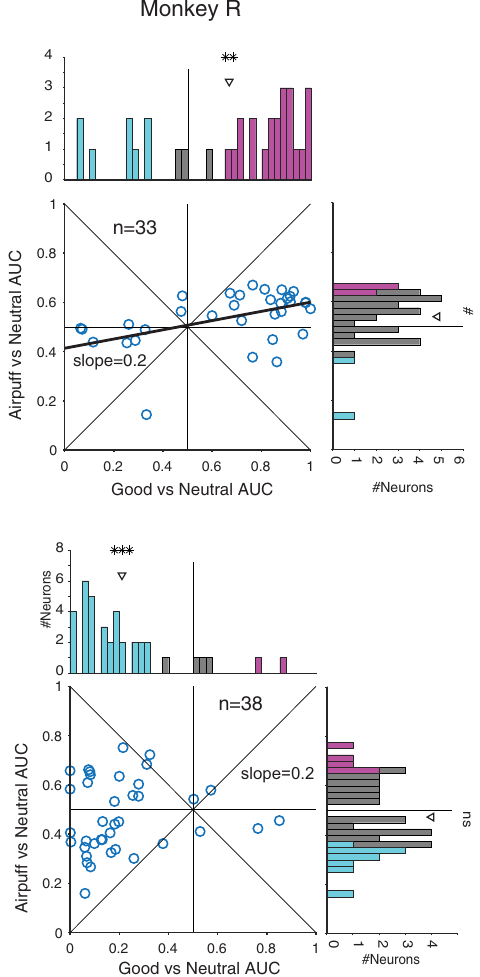
Pearson ’ s ρ =0.59, P =1e-3,valueAUC=0.27 t 26 = − 5.5,P=8e-6,aversiveAUC=0.21 t 26 = − 6.2, P=1e-6, Monkey R: vlPFC Pearson ’ s ρ =0.45, P =9e-3, value AUC=0.66, P =2e-3, aversive AUC=0.53, t P =5e-2, cdlSNr: Pearson ’ s ρ =0.11, t 32 =3.2, 32 =2, − 8.8, P =1e-10,aversiveAUC=0.47 t − 1.14, P =0.2). P =0.5,valueAUC=0.21 t 37 = 37 = Format is similar to Fig. 1g, h. # p =0.05. Source data are provided as a Source Data fi